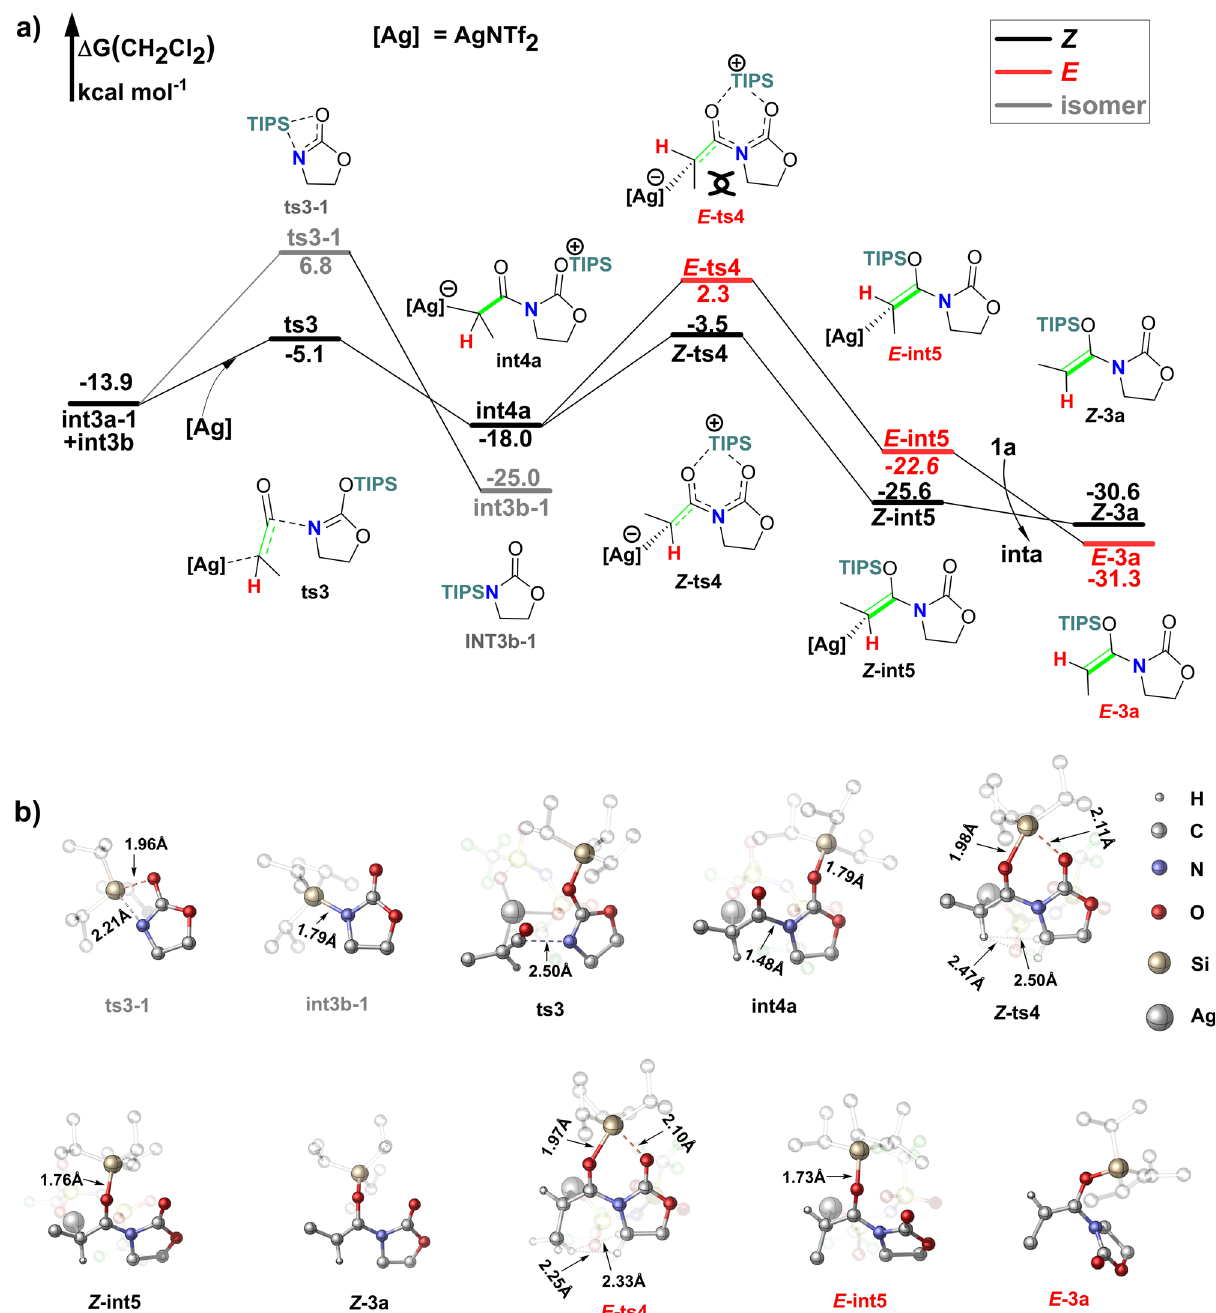
Fig. 5 Ag + promoted nucleophilic addition between ketene and silyl-imine. a Gibbs free-energy pro fi le. Gibbs energies are in kcal mol − 1 . b Optimized geometries. the hydrogen atom of Z -ts4 and E -TS4 was set to transparent, and the hydrogen atoms of the other geometries were omitted, NTf 2 - anion, and the isopropyl of the triisopropylsilyl (TIPS) group was set into transparent for